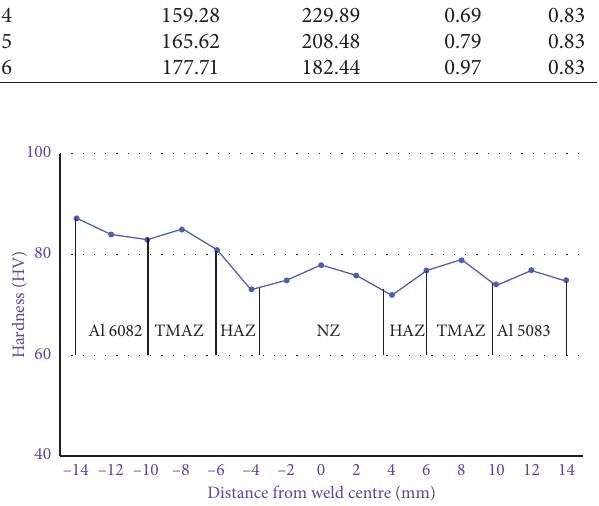
Figure 4: Microhardness survey for sample 4, underwater welded specimen joined at 1000 rpm, 36 mm/min.